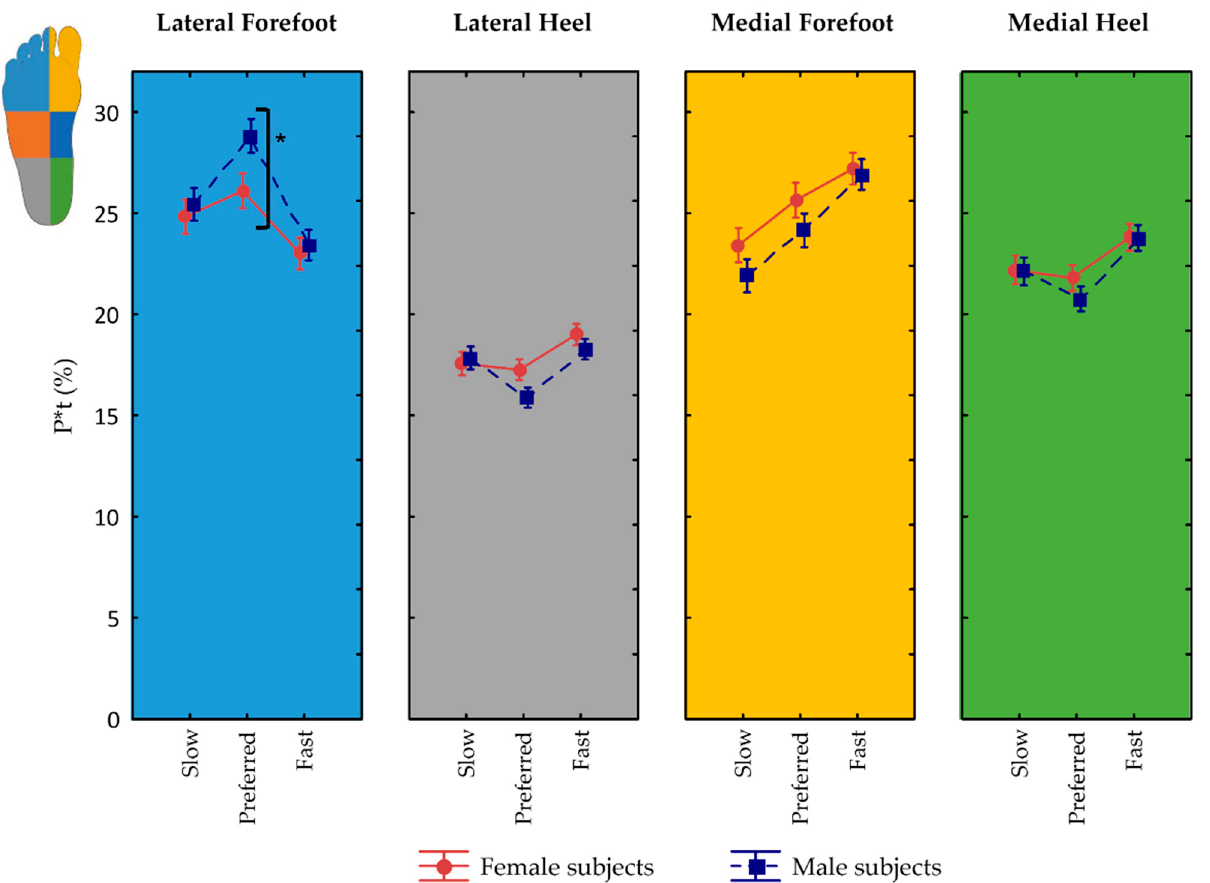
Figure 3. For lateral and medial fore- and rear-foot, P*t in men ( n = 87) and women ( n = 83). Asterisks (*) denote statistically significant differences between women and men in specific plantar pressure zones at each gait speed ( p < 0.05).